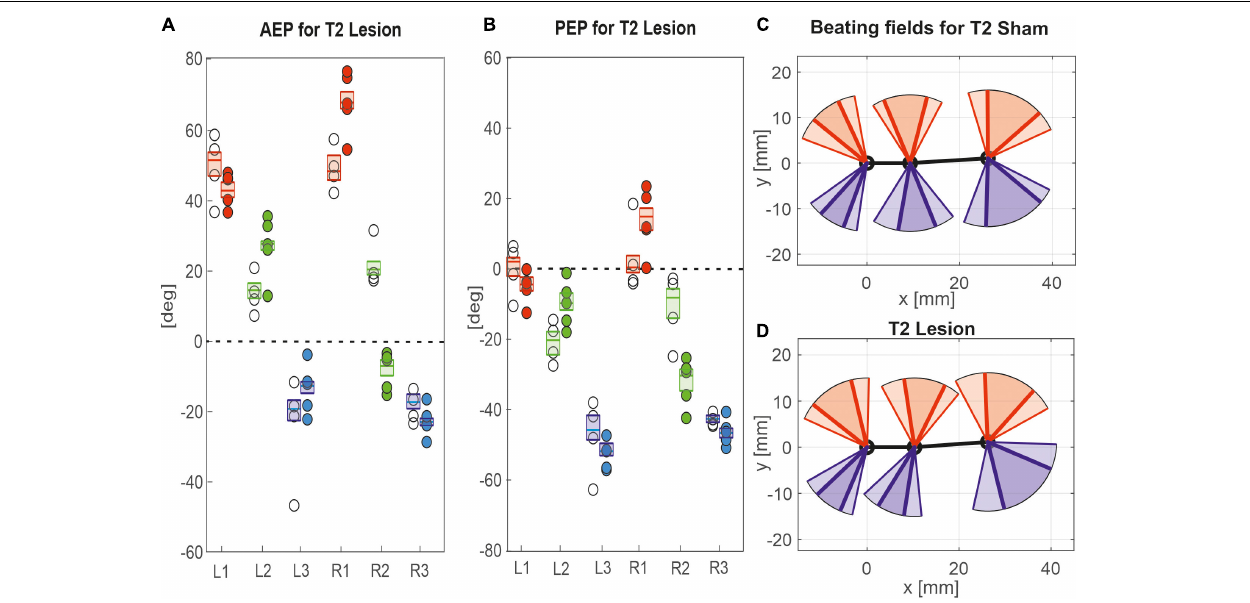
FIGURE 7 | Effects of the T2 lesion on anterior and posterior extreme positions. AEPs (A) and (PEPs (B) of all legs following an operation at the pro-to-mesothorax connective. Symbols show median extreme positions per animal with a cut connective (filled circles) or with a sham operation (open circles). Boxes show the distributions for all trials per cohort with the median extreme positions and 95% CI. Zero degrees (black dashed lines) corresponds to a leg posture orthogonal to the body axis. (C,D) Beating fields show both the size and boundaries of the working range of each leg with a sham operation in the mesothorax ( C , top) or with a cut pro-to-mesothorax connective ( D , bottom). Schematic top views indicate the median femoral postures at the AEP and PEP for the left (red) and right legs (blue) in relation to the body axis (black). Transparent areas show the corresponding 5% percentiles of the PEP and 95% percentiles of the